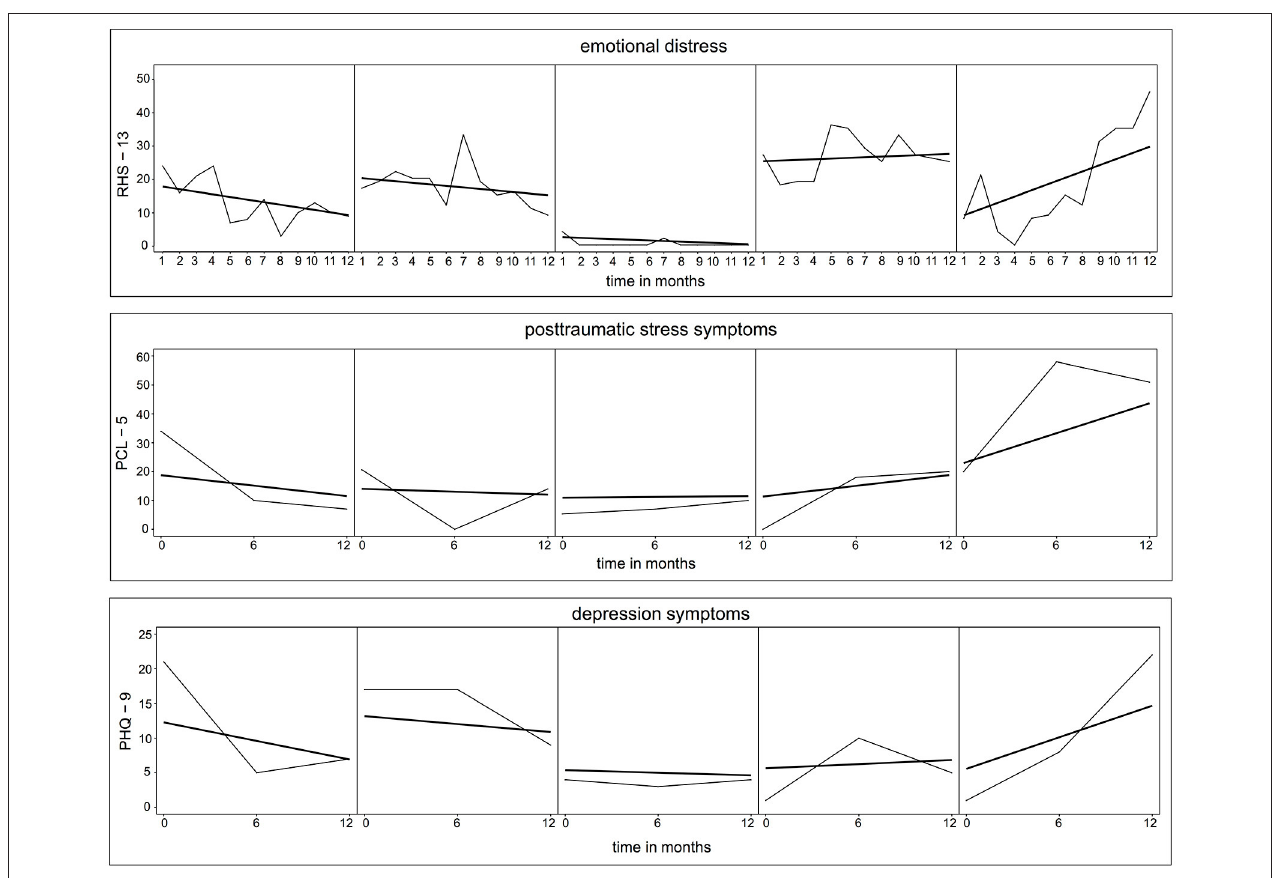
FIGURE 3 | Raw and fitted individual time courses of emotional distress, posttraumatic stress symptoms, and depression symptoms for exemplary participants. Thin lines represent the actual course of symptoms. Bold lines depict the individually predicted LGMs. Selection procedure: Participants were ordered by the gradient of their slope and based on the quartiles exemplary participants were